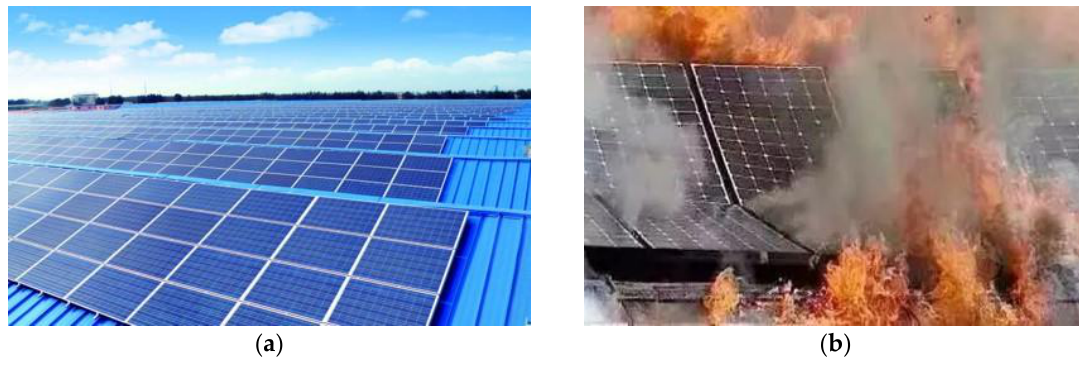
Figure 1. Photovoltaic grid-connected system. ( a ) Photovoltaic power generation devices; ( b ) Fire in photovoltaic systems. [5].